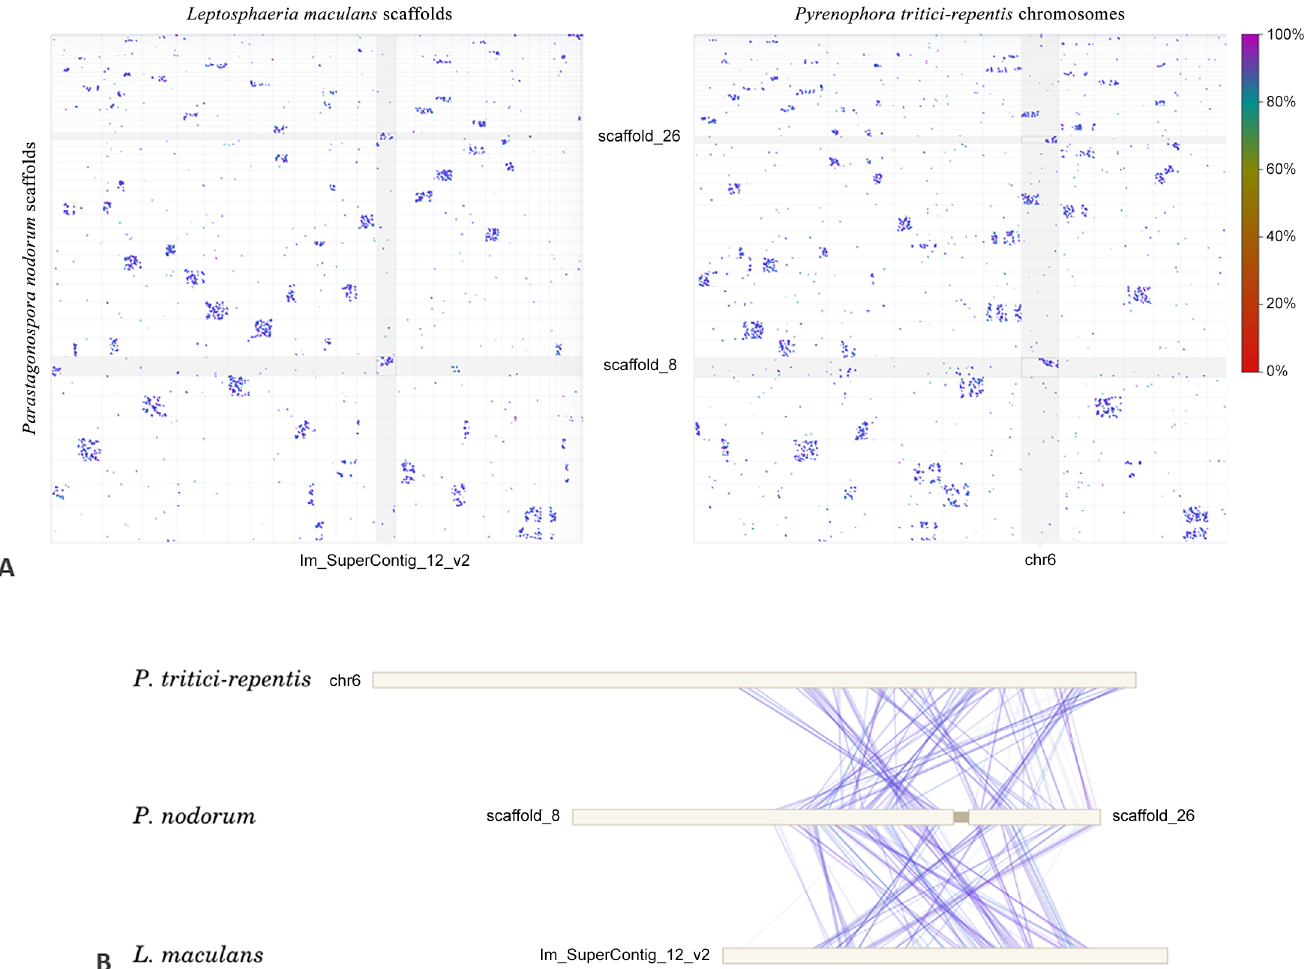
Fig 4. A whole-genome dotplot of nucmer matches between scaffolds of P . nodorum and of P . tritici-repentis . The ‘ dots-in-boxes ’ pattern is indicative of mesosyntenic relationships between chromosomes. P . nodorum scaffolds 8 and 26 are ‘ mesosyntenic ’ versus P . tritici-repentis scaffold 4, as indicated by black